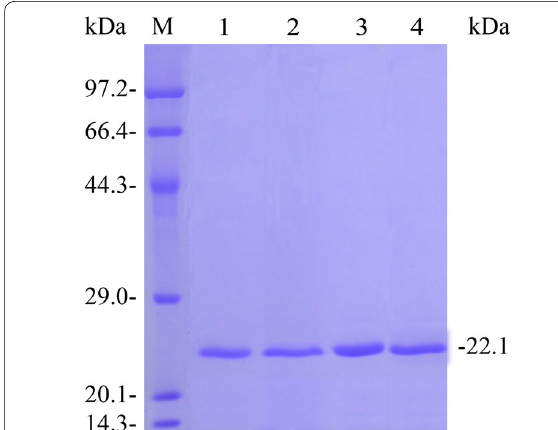
Fig. 4 SDS‑PAGE analysis of the purified reAoXyn11A and its vari‑ ants. Lane M , protein marker; lane 1 – 4 , reAoXyn11A, reAoXyn11A G21I , reAoXyn11A Y13F and reAoXyn11A G21I–Y13F purified from cultured supernatants, respectively